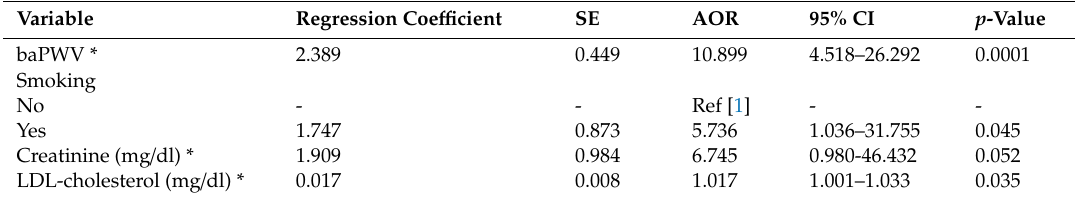
Table 3. Association between brachial-ankle pulse wave velocity and microalbuminuria as determined by multivariable logistic regression analysis **.